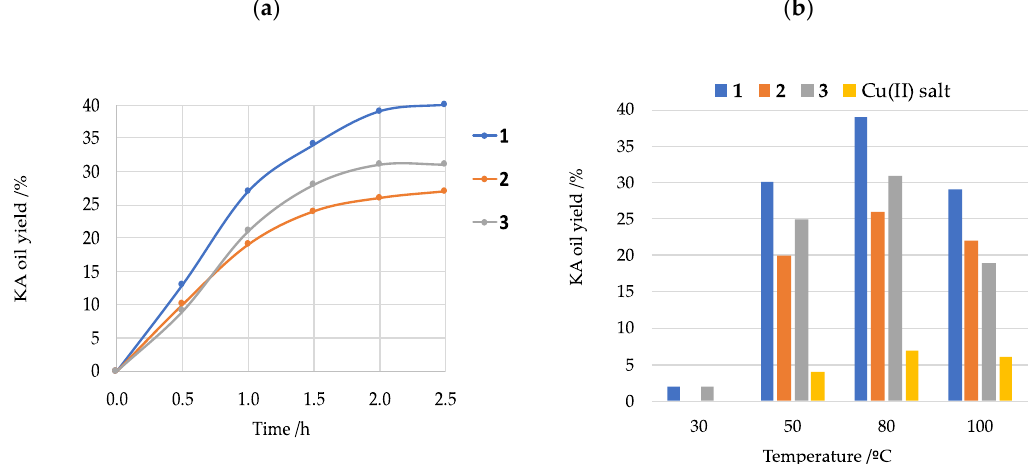
Figure 2. Effect of reaction time ( a , T = 80 ◦ C) and temperature ( b , 2 h) on the yields of ketone-alcohol (KA) oil obtained by the microwave (MW)-assisted oxidation of cyclohexane catalyzed by complexes 1 – 3 .